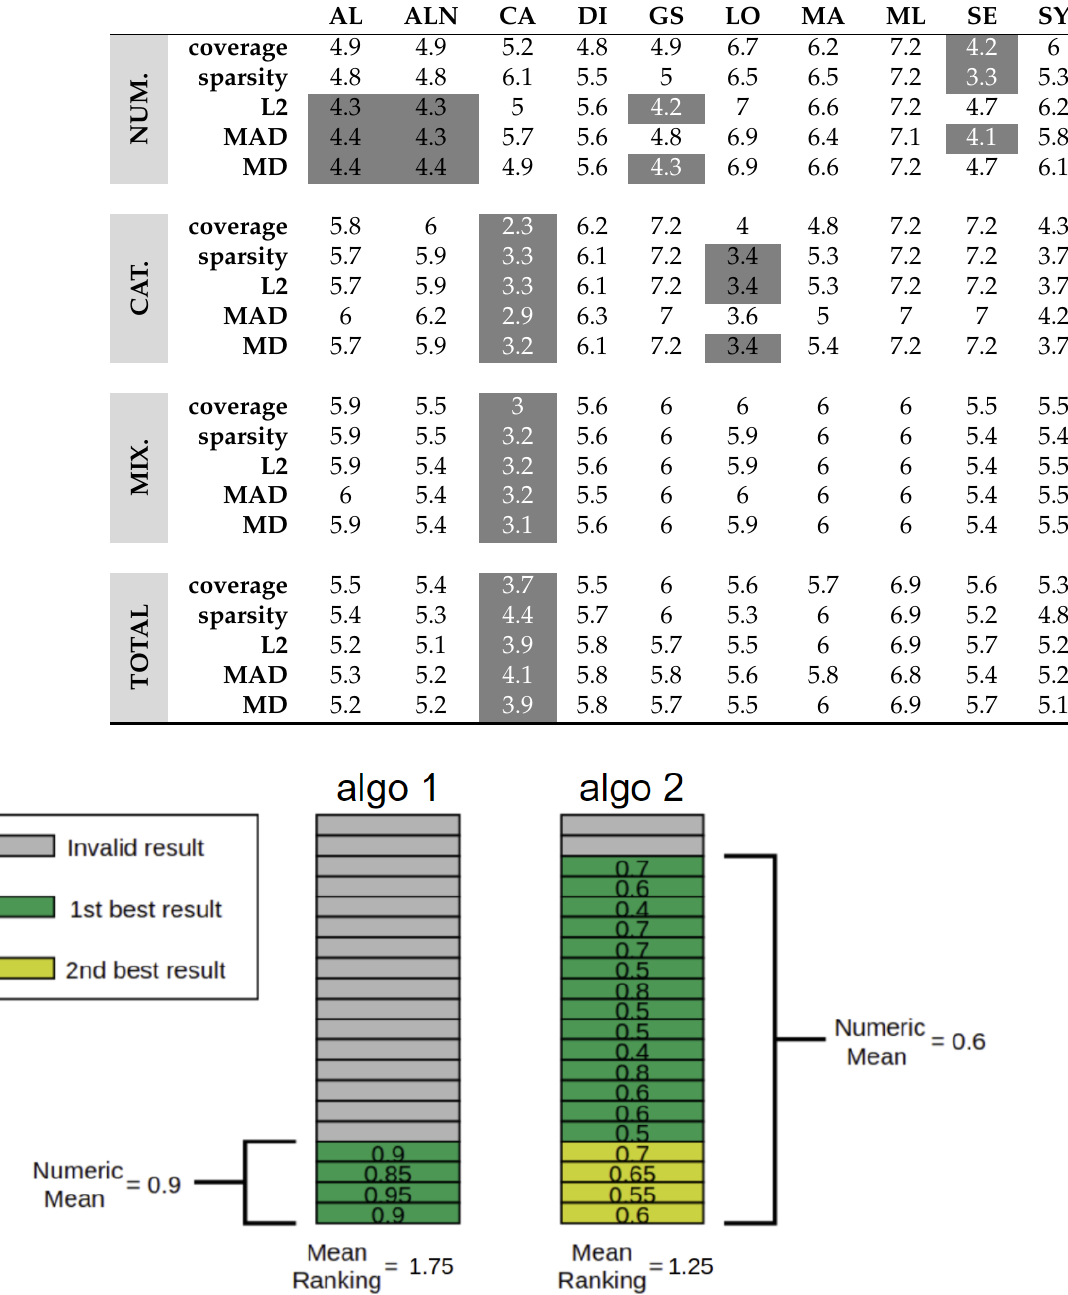
Table 5. Average rankings for dataset groupings, but only considering results that respect the realistic constraint rules. AL : ALIBIC, ALN : ALIBICNOGRAD, CA : CADEX, DI : DiCE, GS : Growing Spheres, LO : LORE, MA : MACE, ML : ML-Explain, SE : SEDC, SY : SynAS.